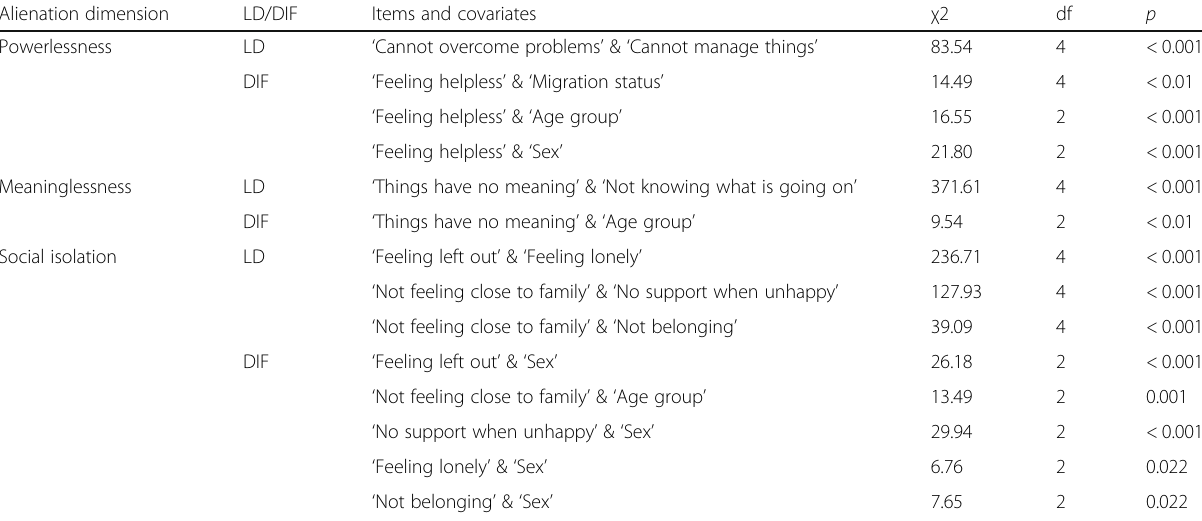
Table 3 DIF and LD present in the three scales Alienation dimension